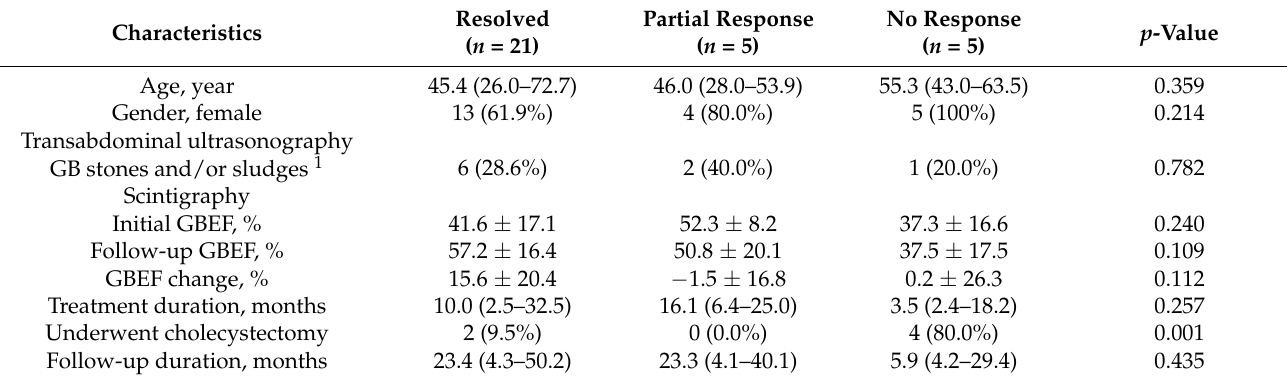
Table 4. Comparison of patients according to clinical